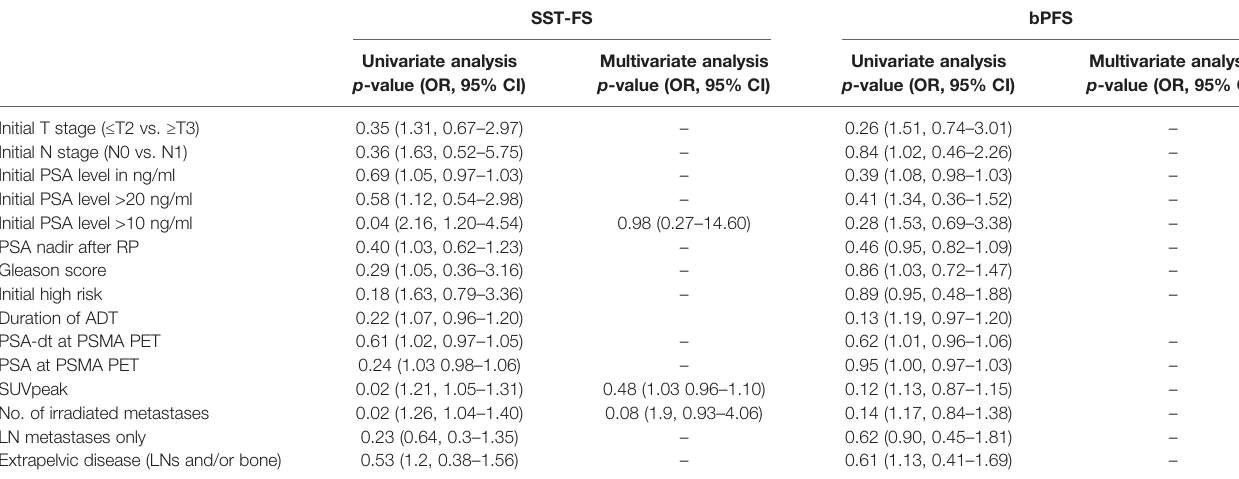
TABLE 3 | Results of fi rst PSMA ligand PET staging prior to PSMA PET-guided radiotherapy and second PSMA ligand PET for restaging after biochemical progression (n = 21). SST-FS bPFS Univariate analysis Multivariate analysis Univariate analysis Multivariate analysis p -value (OR, 95%